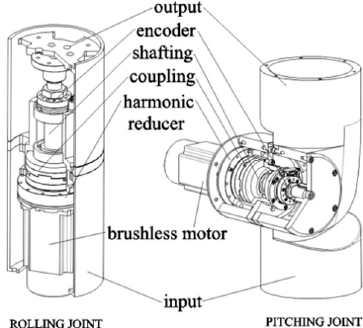
Figure 2. Joint model for a self-driven AACMM [31].